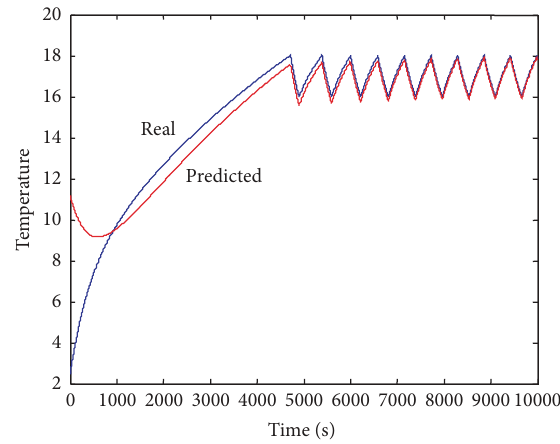
Figure 8: Real and predicted temperature of zone